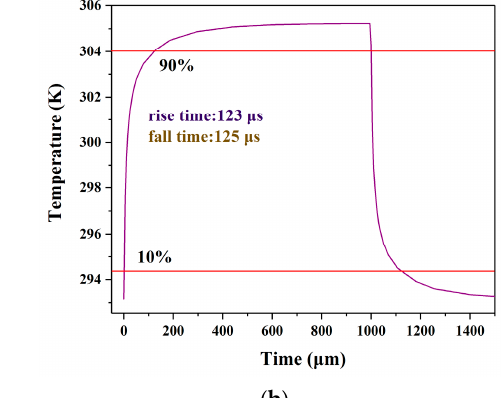
8 of 11 Figure 6. ( a ) Electric field diagram of the first-order mode; ( b ) schematic diagram of thermal field. 3. Results and Discussion The power consumption of the switch is our concern, so we calculated the relation- ship between waveguide temperature variation and pump power. The result shows a lin- ear slope of nearly 1.8614 K/mW in Figure 7a. This means that a temperature change of 1.8614 K in the core can be realized with 1 mW of pump power. When the pump power is 9.6 mW, the phase difference between the two arms of the switch is π to realize switching off. The propagation loss is 1.4 dB/cm. The pump light at 980 nm was set as a square wave signal, and the transient response of the switch was calculated. The switching time ob- tained is shown in Figure 7b, with a rise time of 123 μ s and fall time of 125 μ s. Due to the differences in the upper and lower cladding materials for the waveguide structure used in this paper, the refractive index is different. As such, the smallest part of the first-order mode light field is not in the middle of the waveguide. The optimized result is shown in Figure 8a. When the vertical position of graphene was 1.55 μ m, the propaga- tion loss was 0.01 dB/cm. The switching performance of the optimized structure was sim- ulated. The switching performance was analyzed by FEM. As shown in Figure 8, the re- quired pump power is 9.5 mW, the propagation loss is 0.01 dB/cm, the rise time is 127 μ s, and the fall time is 125 μ s. Comparing the two switching properties, we find that when the graphene is at 1.55 μ m, the propagation loss and power consumption are reduced. As the pump power de- creases, the switching time increases. The above two switches did not have a silicon substrate. In order to improve switch- ing time, a silicon substrate switch was proposed. For a waveguide with a thickness of 3 μ m, when the vertical position of graphene was 1.55 μ m, the propagation loss is 0.07 dB/cm, and the switching performance of the optimized structure was simulated. As shown in Figure 9, the required pump power is 10.3 mW, the propagation loss is 0.07